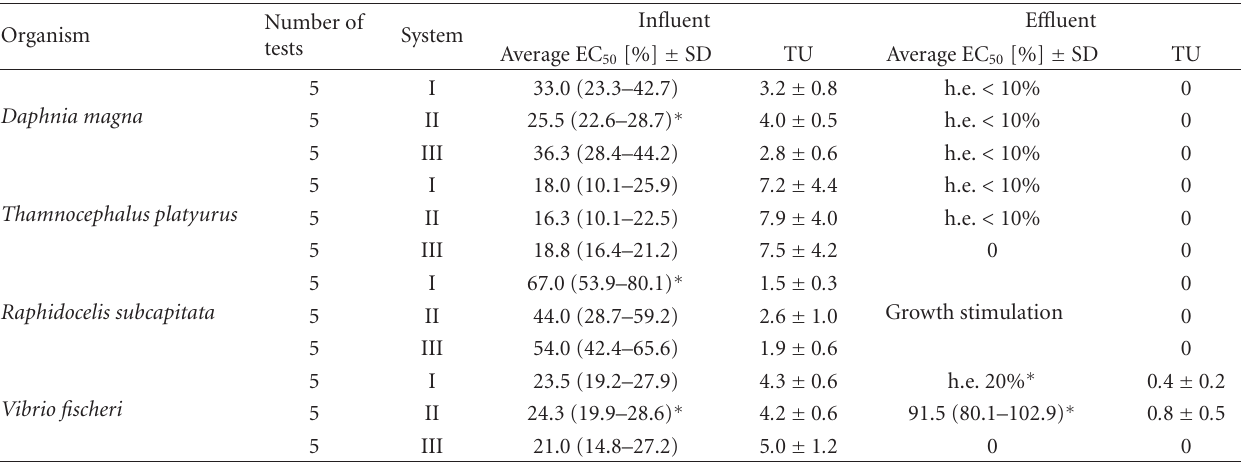
Table 8: Toxicity of raw and treated wastewater (1% of leachate in influent I and II; the 95% confidence limit in parenthesis).